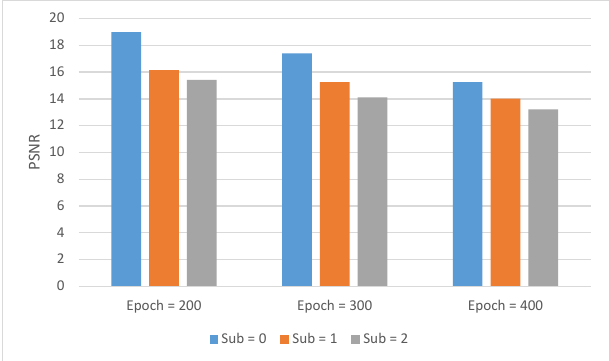
Figure 12. PSNRs according to the epoch number and subdivision surfaces.